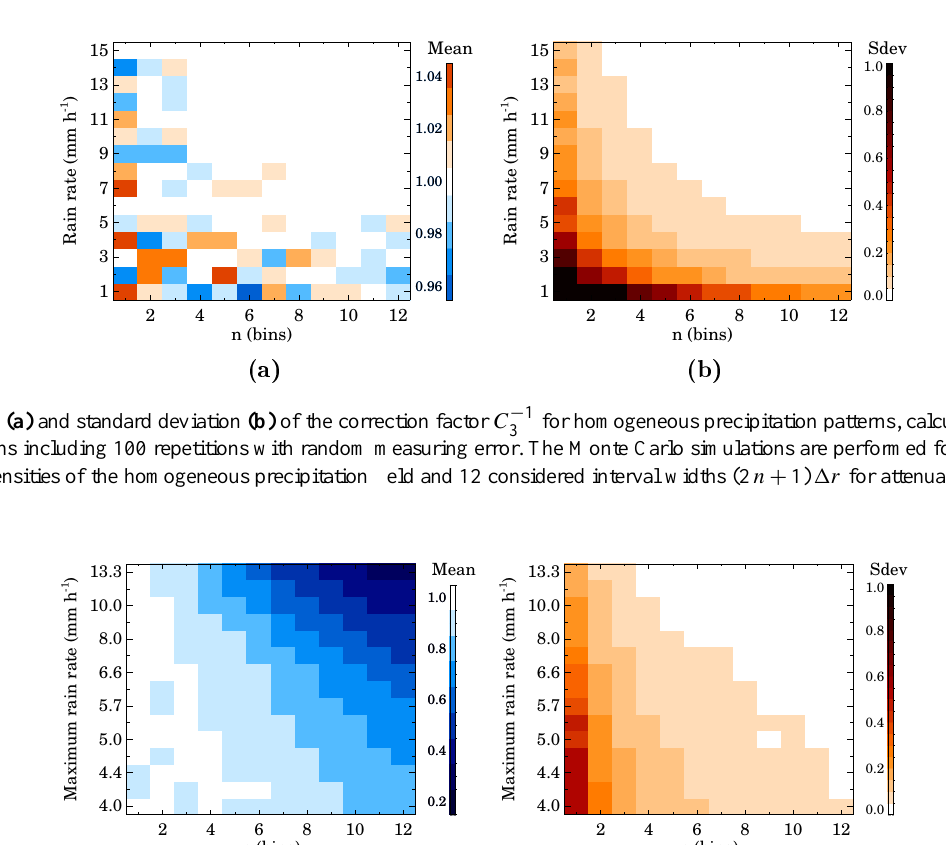
Figure 5. Mean (a) and standard deviation (b) of the correction factor C − 1 for Gaussian-shaped rain fields, calculated from Monte Carlo sim- 3 ulations including 100 repetitions with random measuring error. The Monte Carlo simulations are performed for combinations of 15 different rainfall intensities and 12 considered interval widths (2 n + 1) (cid:49)r for attenuation determination above R 3